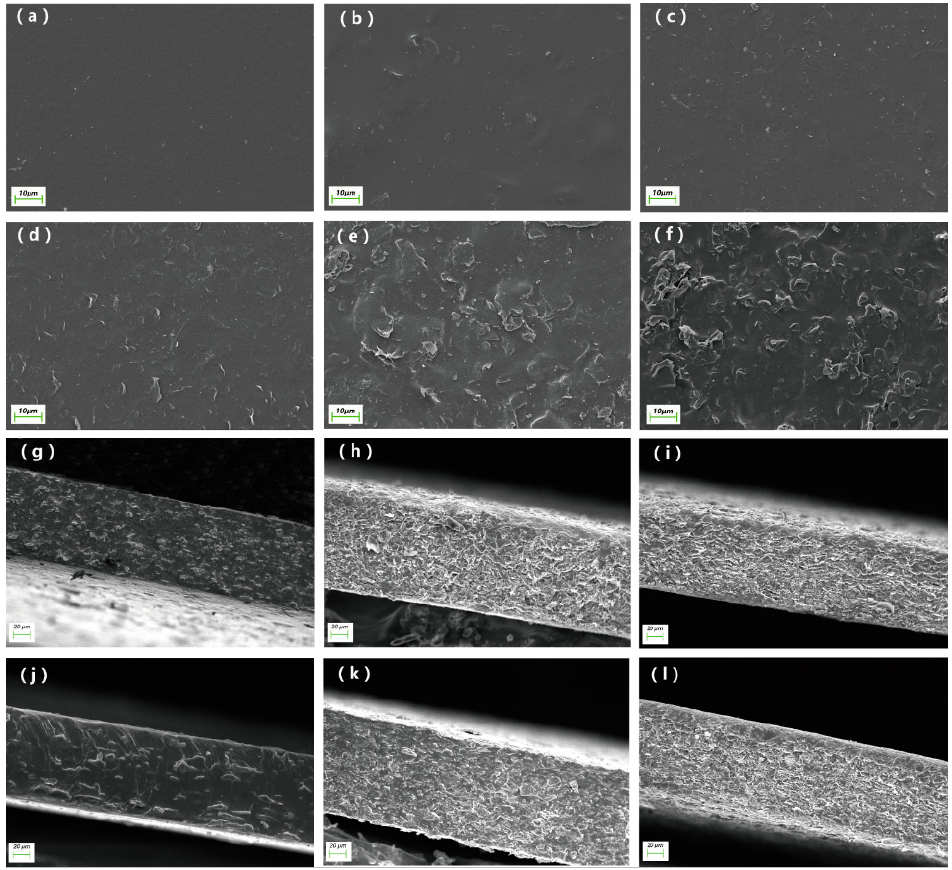
Figure 5. SEM images of the surfaces for the neat PU and MG/PU composites with various modified